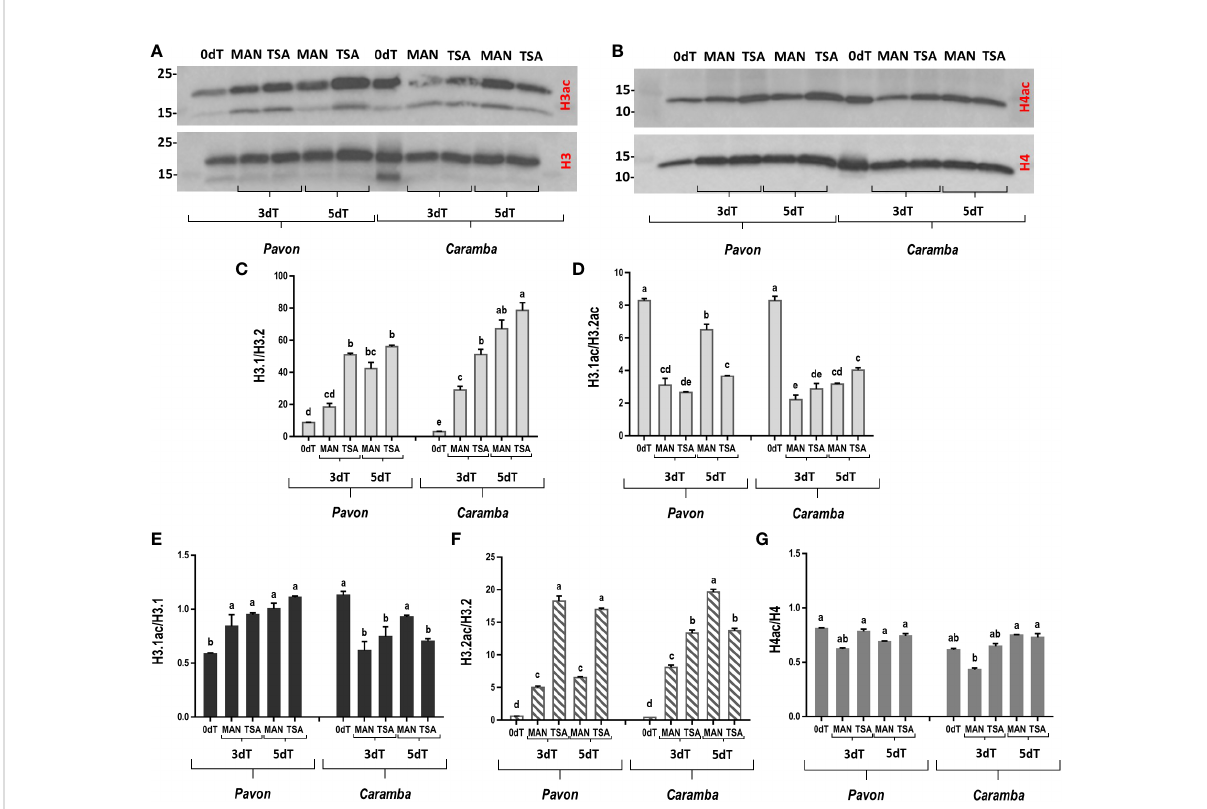
FIGURE 1 Effect of MAN and TSA treatments on histones H3 and H4 acetylation. (A, B) Immunoblot of histones H3 and H4 and pan-acetylated H3 and H4 (H3ac and H4ac, respectively). (C, D) Quantitative analysis of the H3.1/H3.2 and H3.1ac/H3.2ac ratios, respectively. (E, F) Quantitative analysis of the H3.1 and H3.2 acetylation ratio (G) Quantitative analysis of the H4 acetylation ratio. Microspores before stress treatment (0dT), after 3 and 5 days with mannitol treatment (3dT-MAN, 5dT-MAN), and after 3 and 5 days with mannitol plus TSA treatment (3dT-TSA, 5dT-TSA) from Pavon (on the left) and Caramba (on the right). Bars represent the standard errors of the means. Histone H3.1/H3.2, H3.1ac/H3.2ac, H3.1ac/H3.1, H3.2ac/H3.2 and H4ac/H4 ratios with the same letter within each ratio are not signi fi cantly different (P ˂ 0.05) according to the Duncan